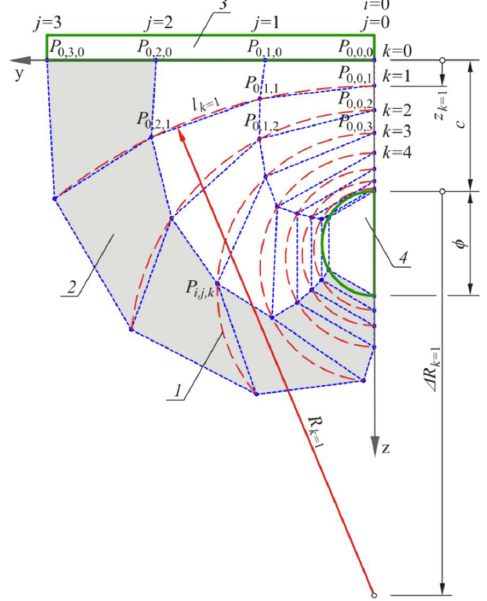
Figure A1. Criteria for determining guide parameters 1 for theoretical conductive paths 2 running between the counter electrode 3 and the rebar 4.